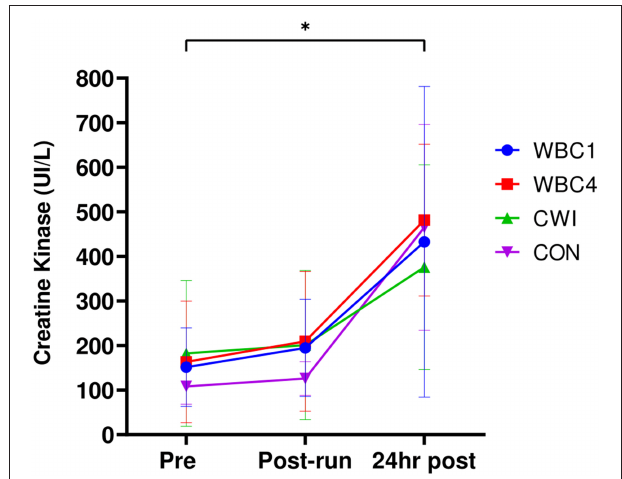
FIGURE 4 | Blood CK values for WBC1, WBC4, CWI and CON groups. * p < 0.05 for increase at 24h post for all groups. Data presented as means ± standard deviations. N = 33.